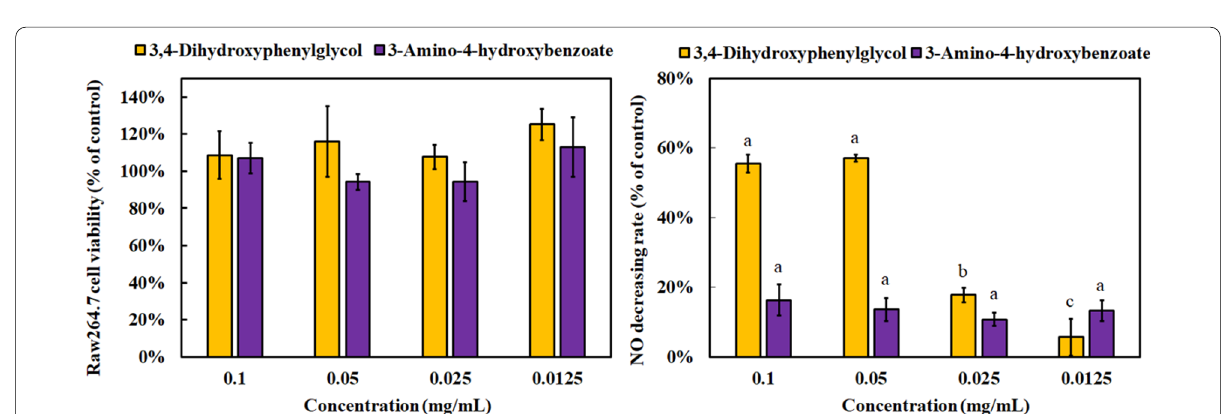
Fig. 9 Raw264.7 cell viability and anti‑inflammatory capacity of 3,4‑dihydroxyphenylglycol and 3‑amino‑4‑hydroxybenzoate using MTT method and LPS‑stimulated Raw264.7 cells. Results are mean